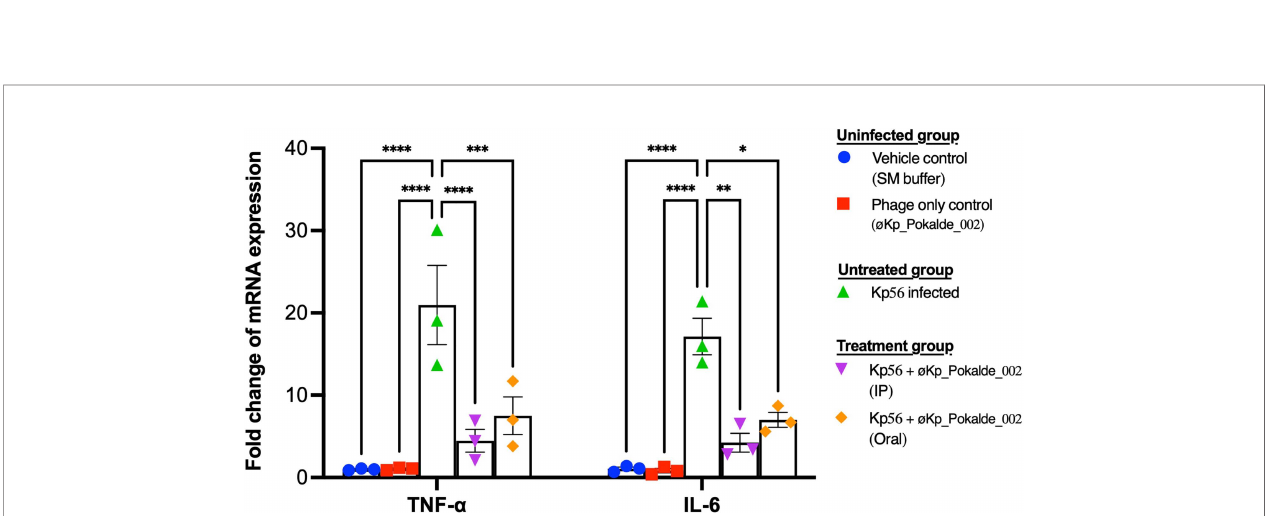
FIGURE 5 | Pro-in fl ammatory cytokine TNF- a and IL-6 levels in the plasma of mice (24 h post infection). Both TNF- a and IL-6 mRNA levels were signi fi cantly higher in Kp56 infected mice compared to uninfected and treated mice (p < 0.05) via both IP and oral routes. There was negligible fold increment of TNF- a and IL-6 mRNA level in vehicle control (SM buffer) and phage only control (øKp_Pokalde_002). Levels of TNF- a and IL-6 mRNA were normalized to b -actin mRNA levels and were expressed as n-fold (2 - ΔΔ Ct ) increase with reference to the control groups. Results are shown as means ± SEM from triplicate experiments. The y-axis values represent the fold changes of mRNA relative to the b -actin mRNA in the same sample. The statistical comparison was done by two-way ANOVA. *p < 0.05, **p < 0.01, ***p < 0.001, ****p < 0.0001.